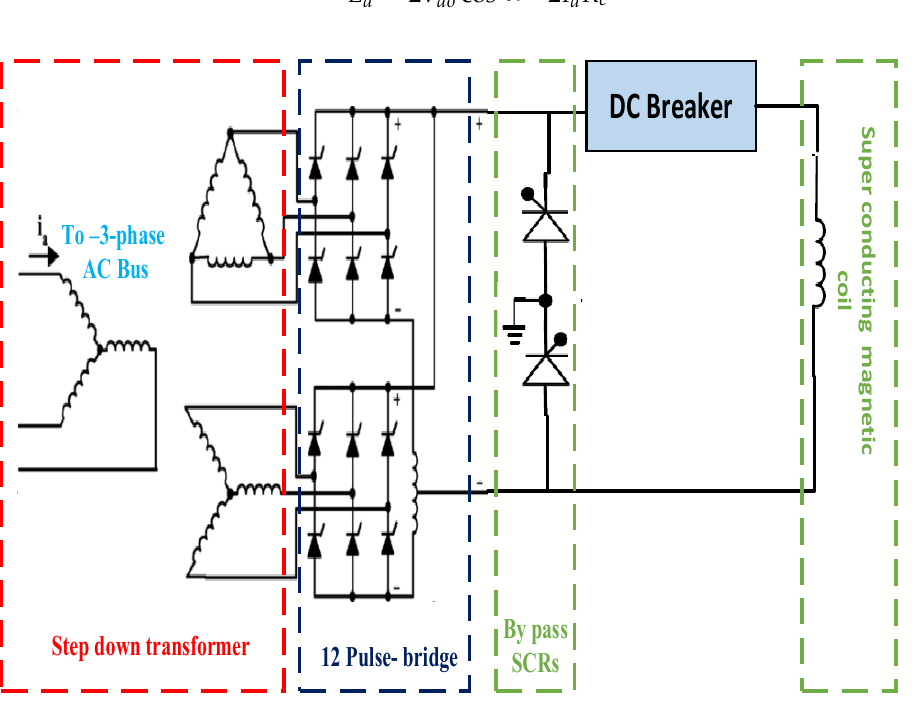
Figure 4. The SMES’s basic form.